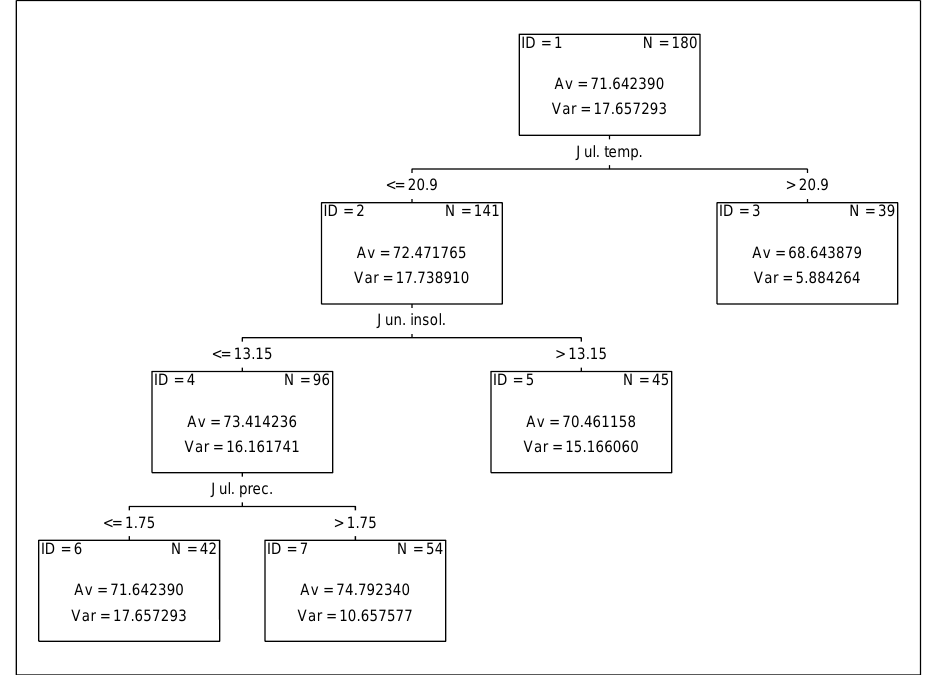
Figure 11. Diagram of regression tree reflecting nitrogen acquisition from soil by soybean plants treated with Asahi.